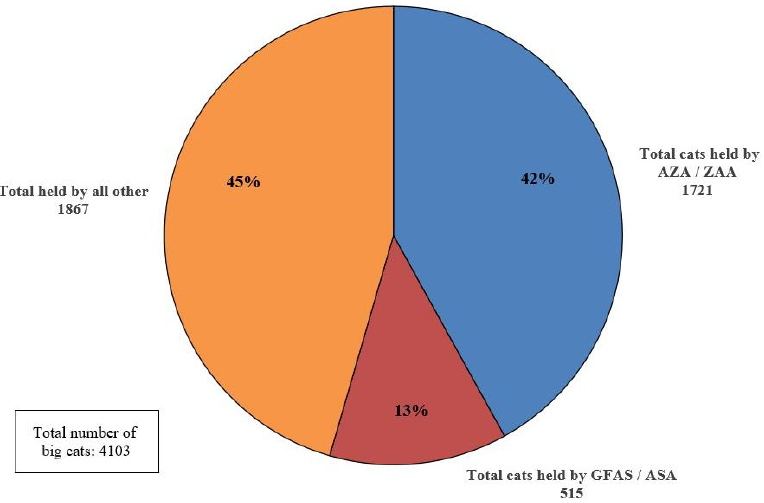
Figure 4. The total number of big cats in federally regulated facilities, sorted by facility accreditation.